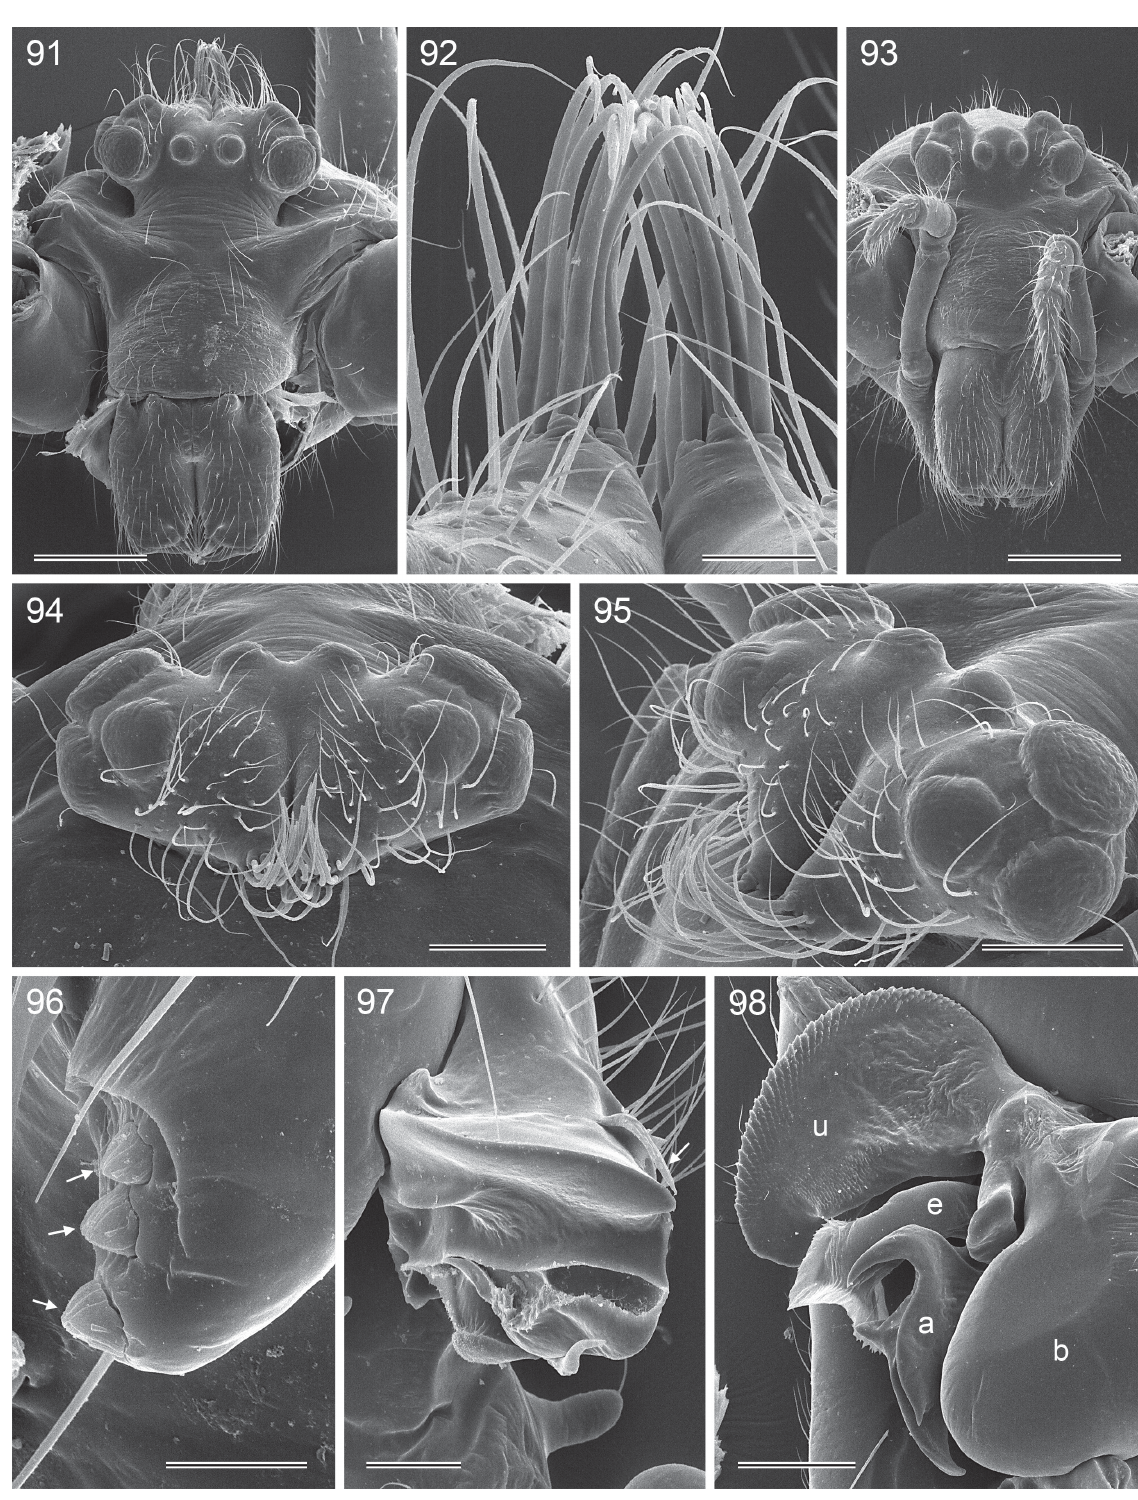
Figs 91–98. Pholcus pagbilao Huber, 2011, ZFMK Ar 15515–16. 91 . Male prosoma, frontal view. 92 . Male ocular horns and modified hairs. 93 . Female prosoma, frontal view. 94–95 . Male ocular area, dorsal and latero-dorsal views. 96 . Male distal cheliceral apophysis (arrows point at modified hairs). 97 . Left procursus, dorsal view (arrow points at semitransparent process). 98 . Left genital bulb, prolateral view. Scale lines: 91, 93 = 400 µm; 92 = 60 µm; 94–95, 98 = 200 µm; 96 = 20 µm; 97 = 100